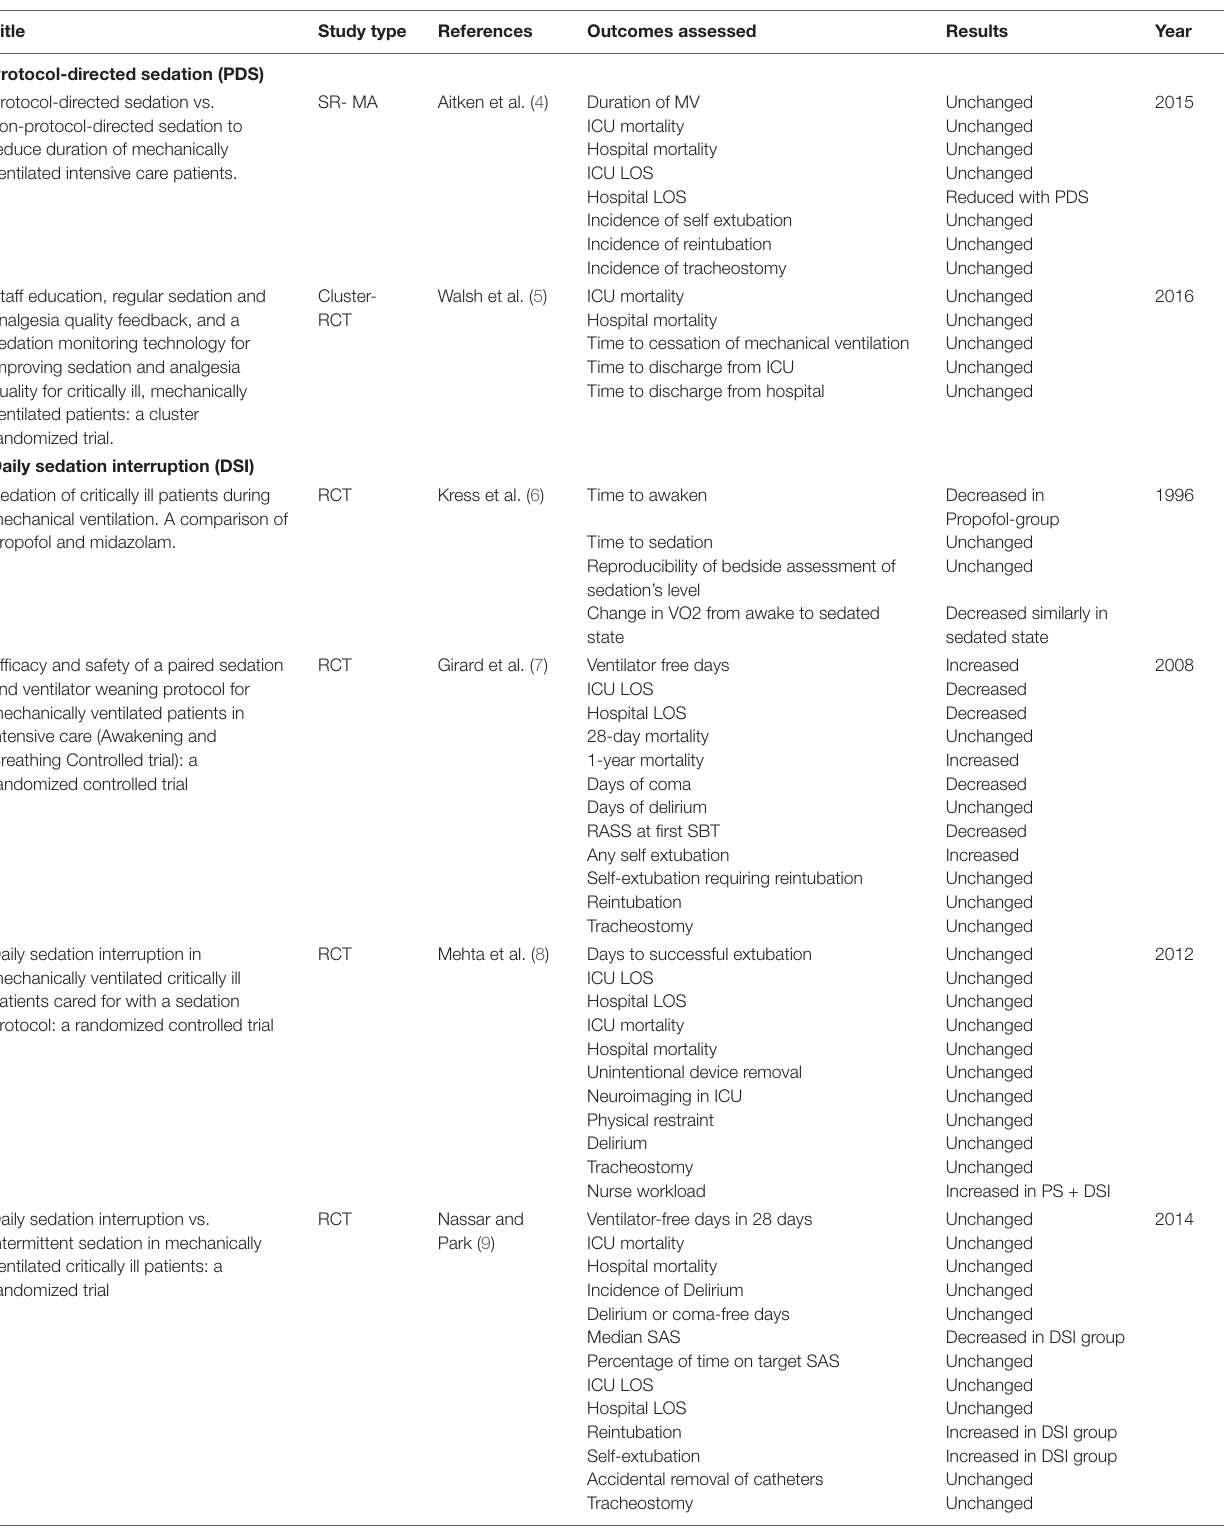
TABLE 1 | Summary of studies mentioned in the